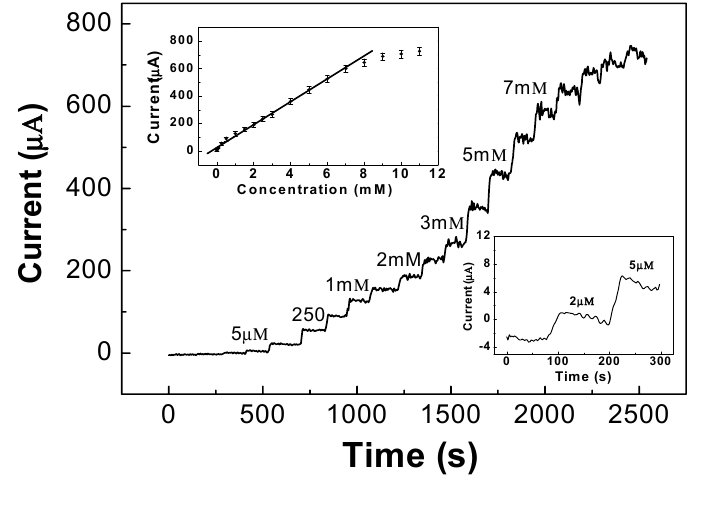
glucoses in 0.1 M NaOH solution. Upper-inset: The calibration curve of current vs. concentration of glucose; Error bars indicate the standard deviations of three measurements. Lower-inset: Amperometric response to 2 and 5 µM glucose